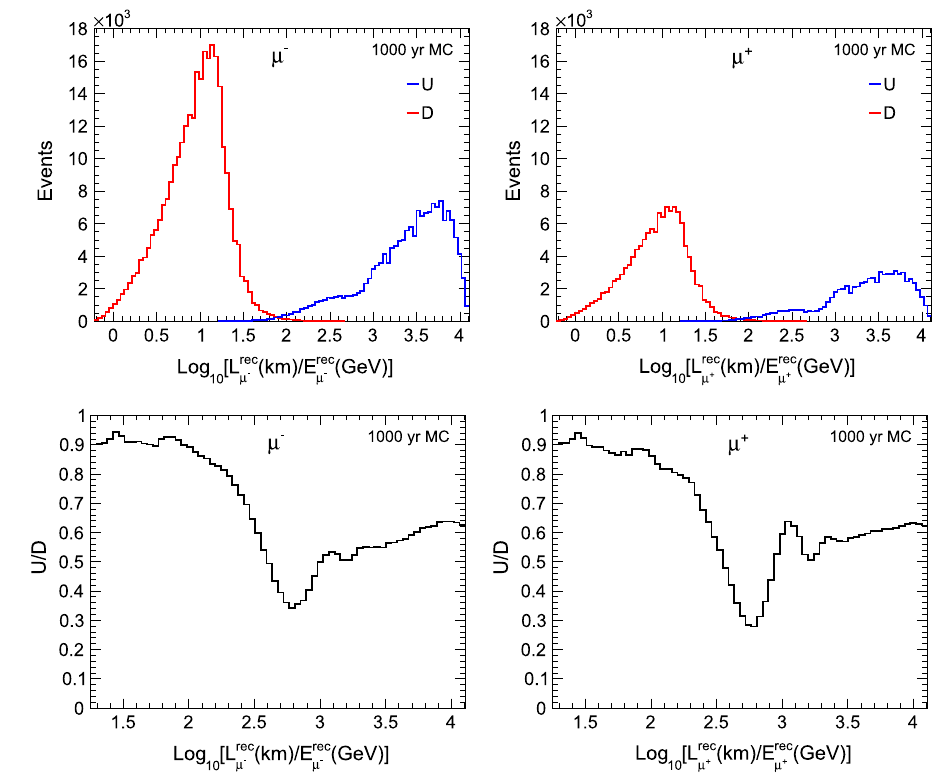
Fig. 3 Upper panels: the expected log 10 [ L rec μ / E rec μ ] distributions of μ − (left panel) and μ + (right panel) events. The upward-going and downward-going events are represented with blue and red lines respectively. Lower panels: the U/D ratios as functions of log 10 [ L rec μ / E rec μ ] of μ − (left panel) and μ + (right panel). All of these results are obtained with the 1000-year MC data sample. The E rec μ lies in the range of 1–25 GeV. We use the oscillation parameters given in